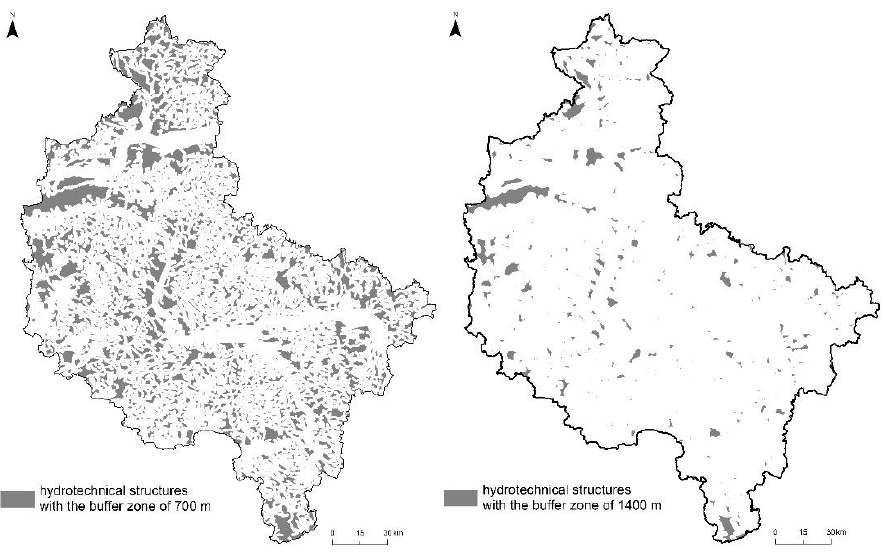
Figure 5. Area available for wind energy development — flood plains with the buffer zones of 700 m and 1400 m in the Greater Poland Voivodeship (own calculations).